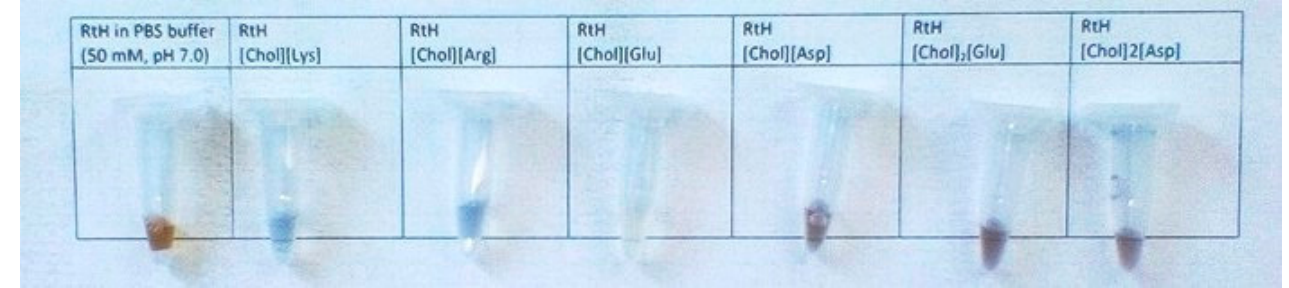
Figure 2. Samples stored at room temperature for 3 months.